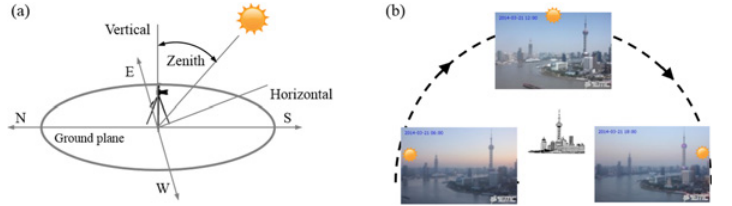
Fig 8. Sky color dependence on solar zenith angle. (a) Definition of solar zenith angle. (b) Sample images show that the sky near horizon is red during sunrise and sunset on the same day compared with noon